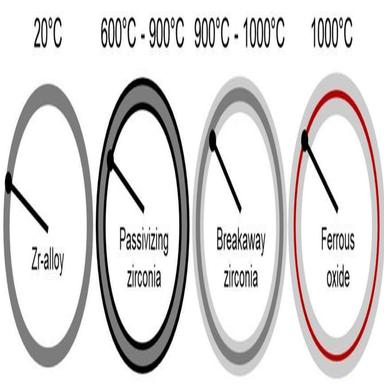
Changes in material color as oxides develop on the interior and exterior of the OPZ tube.